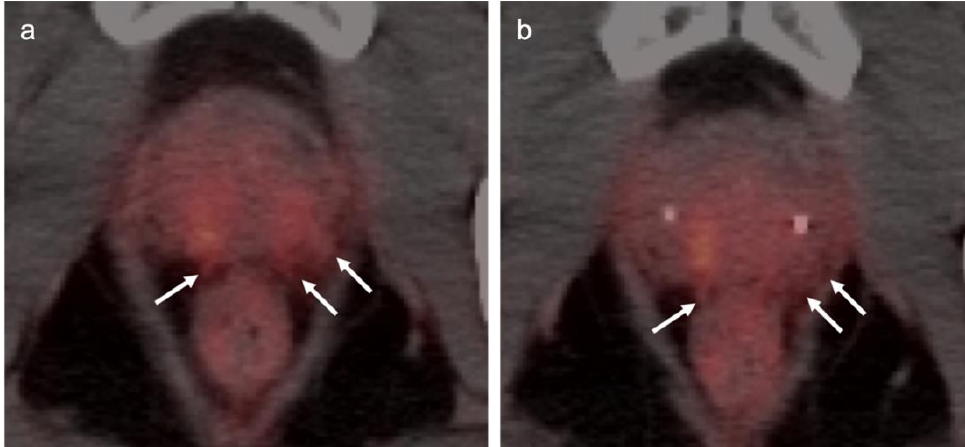
Figure 30. Subtle extra-prostatic spread of prostate cancer on PSMA PET-CT. ( a , b ) Axial PSMA PET-CT images demonstrate moderately PET-positive tumor in the posterior peripheral and transitional zones of both lobes of the prostate. The posterior capsule of the prostate is indistinct and shows stranding soft tissue that is PET avid (white arrows), supporting extracapsular spread of disease. The patient had bilateral transitional and peripheral zone tumor by biopsy.